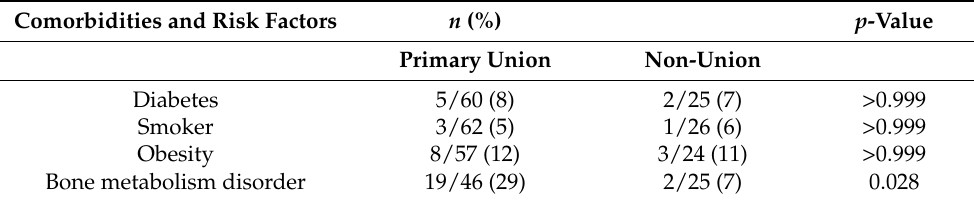
Table 1. Correlation between union and comorbidities and risk factors.